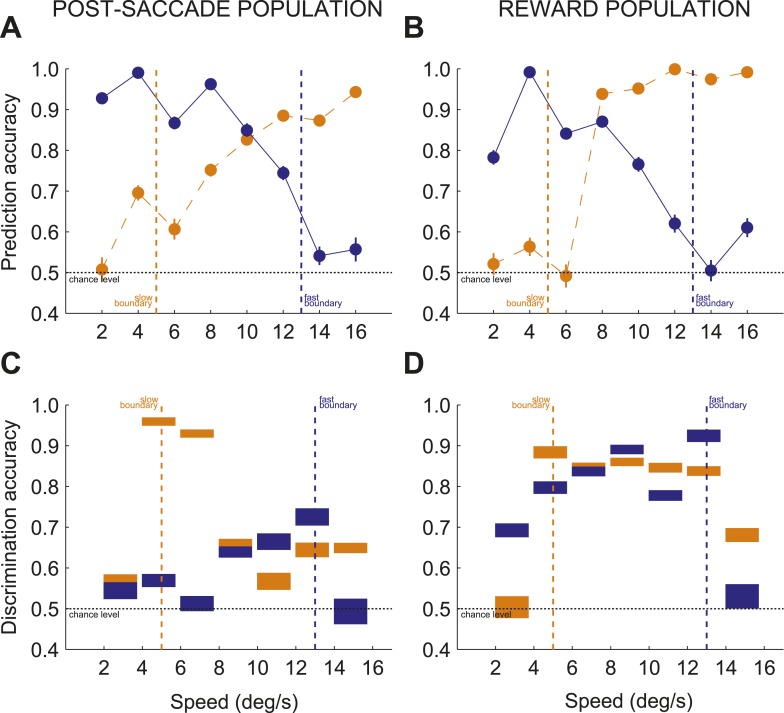
Contextual modulation during categorization.(A and B) Prediction accuracy for two opposite directions of dots motion (up or down) for each stimulus for post-saccade (A) and reward (B) neuronal populations. (C and D) Discrimination accuracy across pairs of neighboring speeds (seven pairs, 2–4, 4–6, …, 14–16) separately for trials with each boundary position for post-saccade (C) and reward (D) neuronal populations. The thickness of each bar corresponds to the average discrimination accuracy with ± SEM. Same notation as in above.